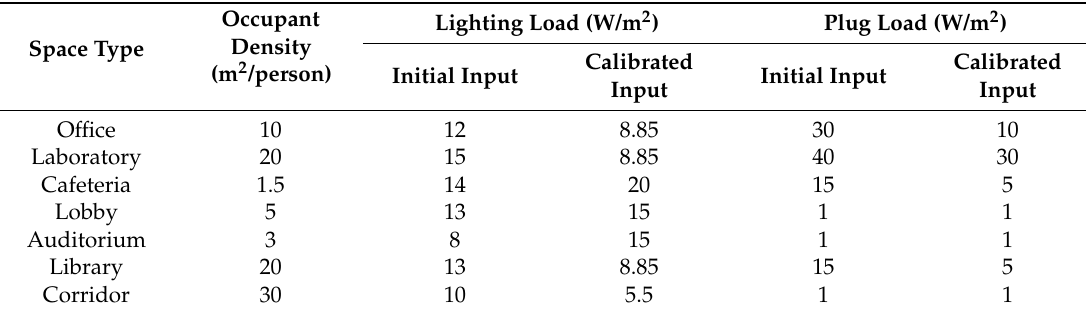
Table 4. Internal load condition between initial and calibrated model.